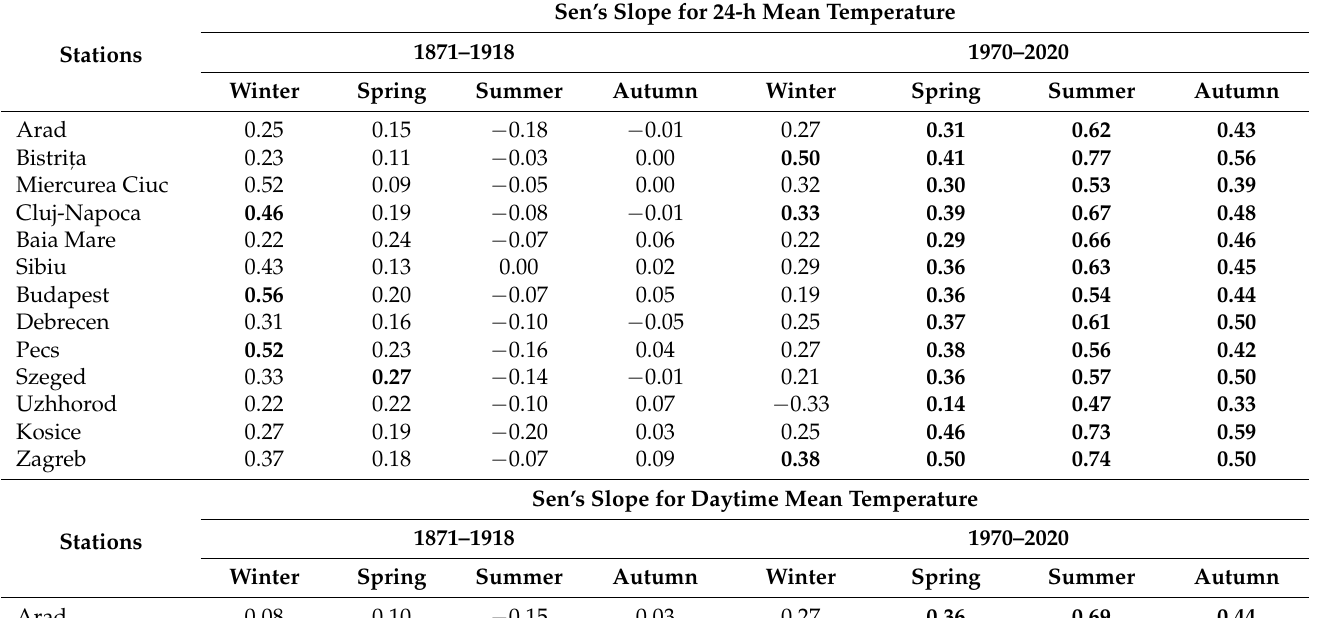
Table 2. Trend ( ◦ C/decade) of daily (24 h) and daytime mean temperature for historical (1871–1918) and current (1971–2020) periods in the Carpathian Region. Bold values indicate significant changes at the 0.05 significance